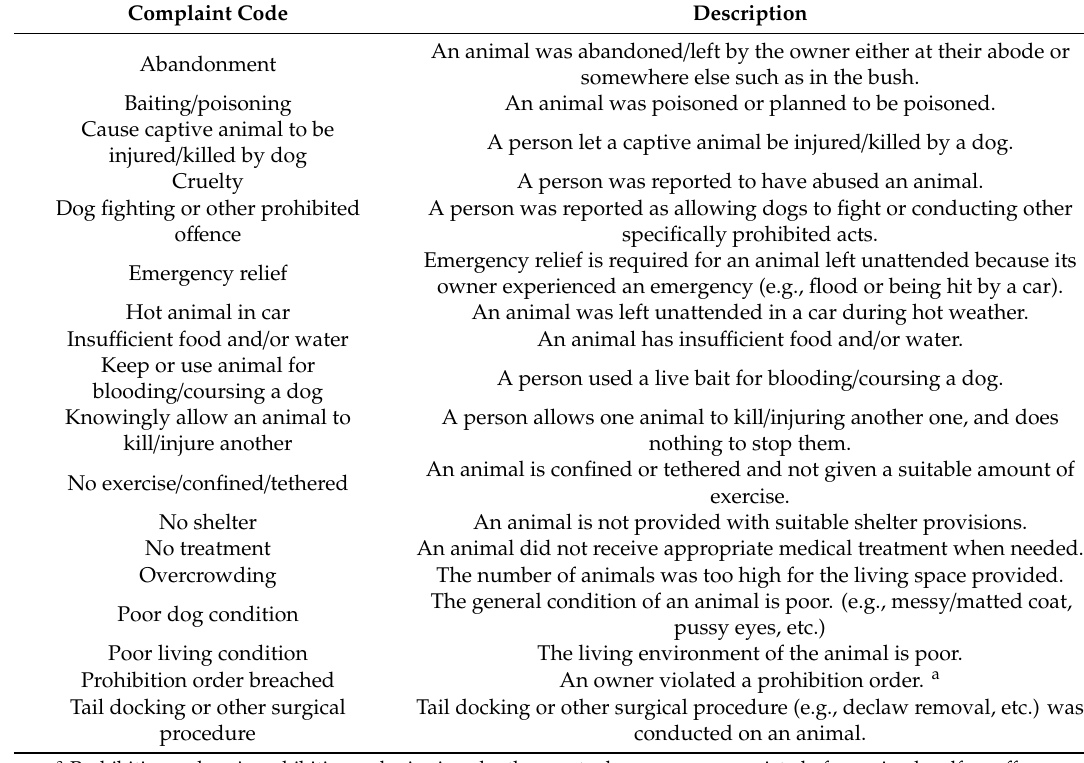
Table A1. Description of each complaint code alleging a welfare issue.